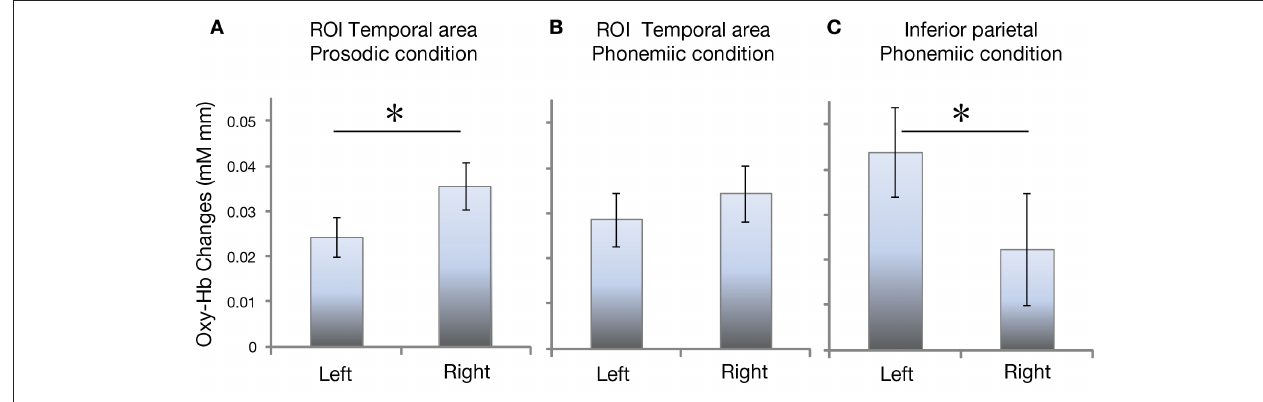
FIguRe 5 | Averaged oxy-Hb changes in ROI (A,B) and inferior parietal (C) channel for different condition. Error bars indicate SE. * = p < 0.05 (corrected).